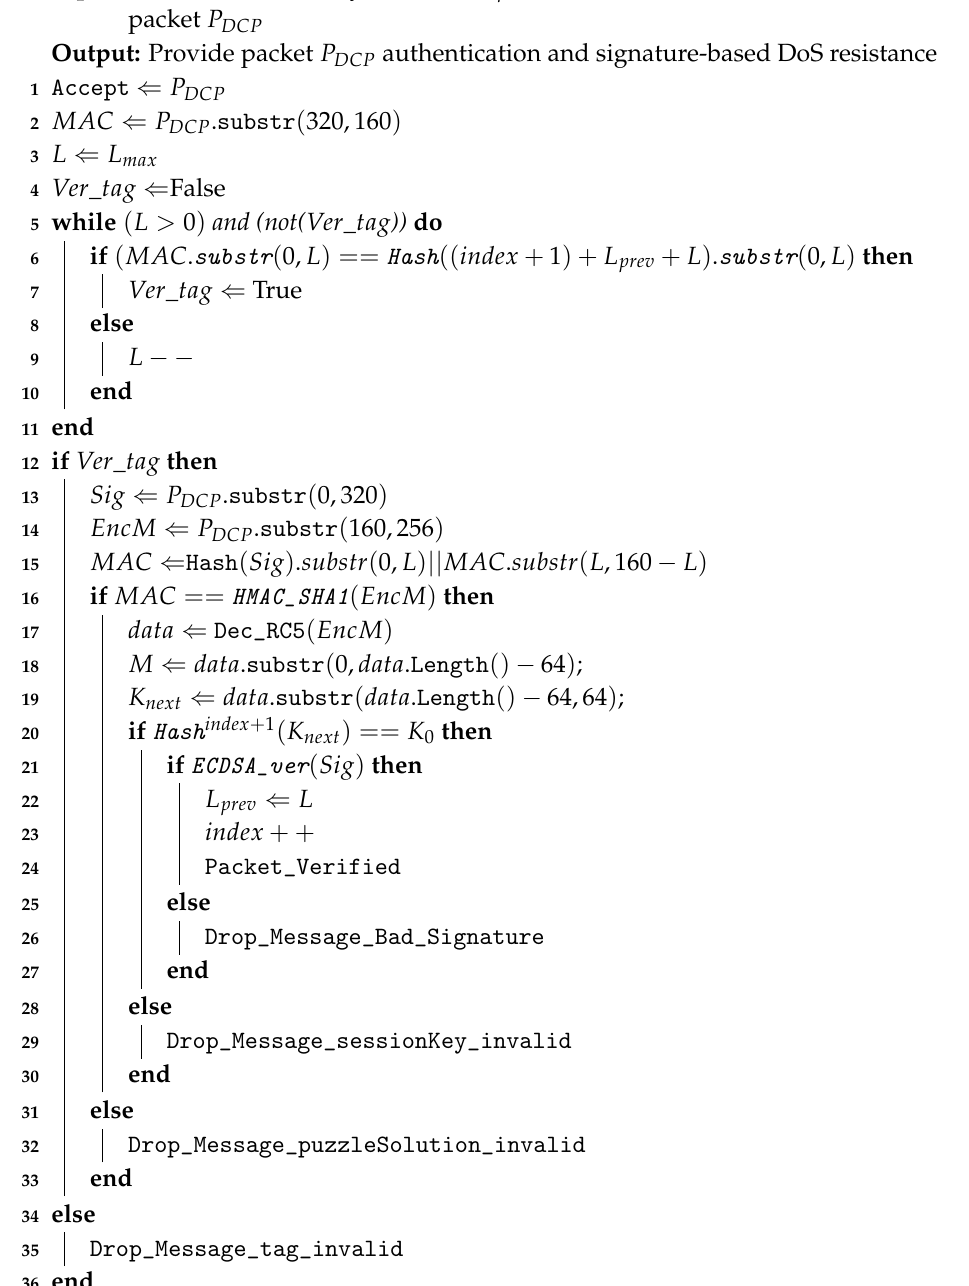
Algorithm 2: Dynamic Cipher Puzzle verification at the